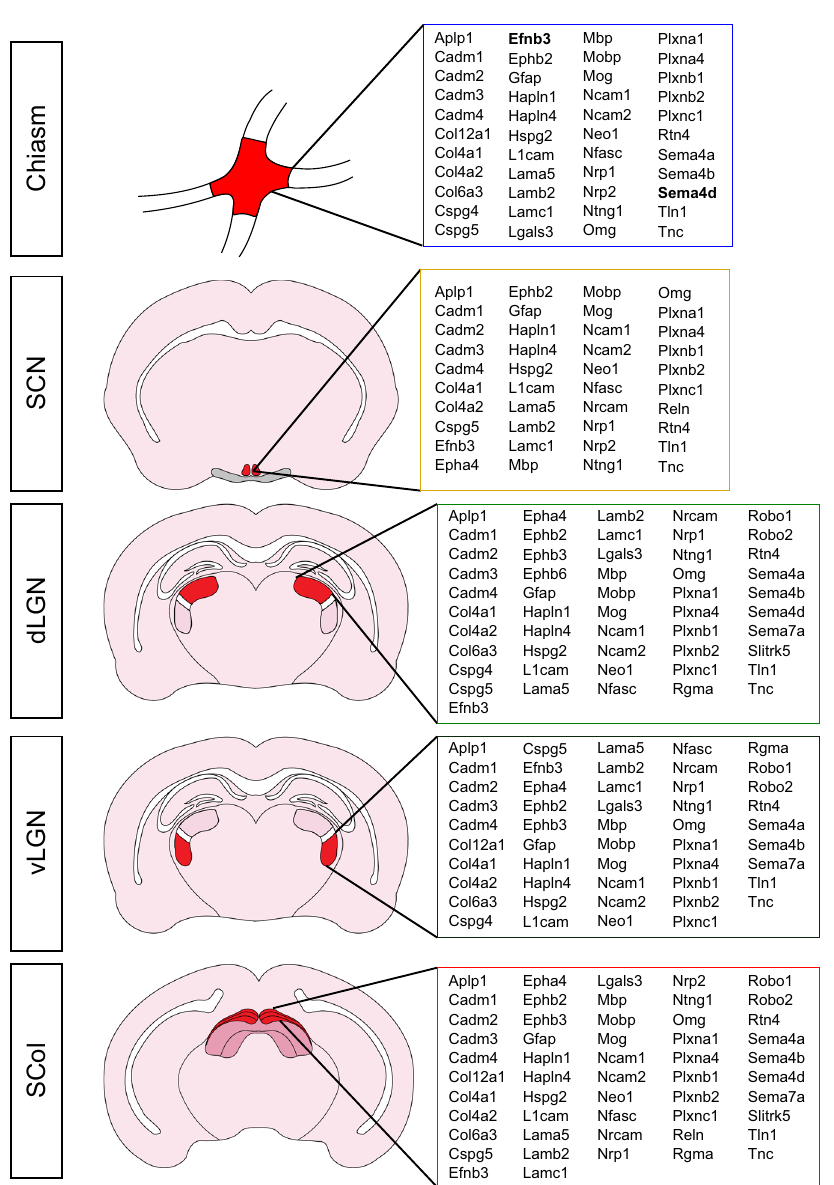
study for each brain target of the adult visual system. Proteins of interest are in bold. SCN suprachiasmatic nucleus, LGN lateral geniculate nucleus, v ventral, d dorsal, SCol superior